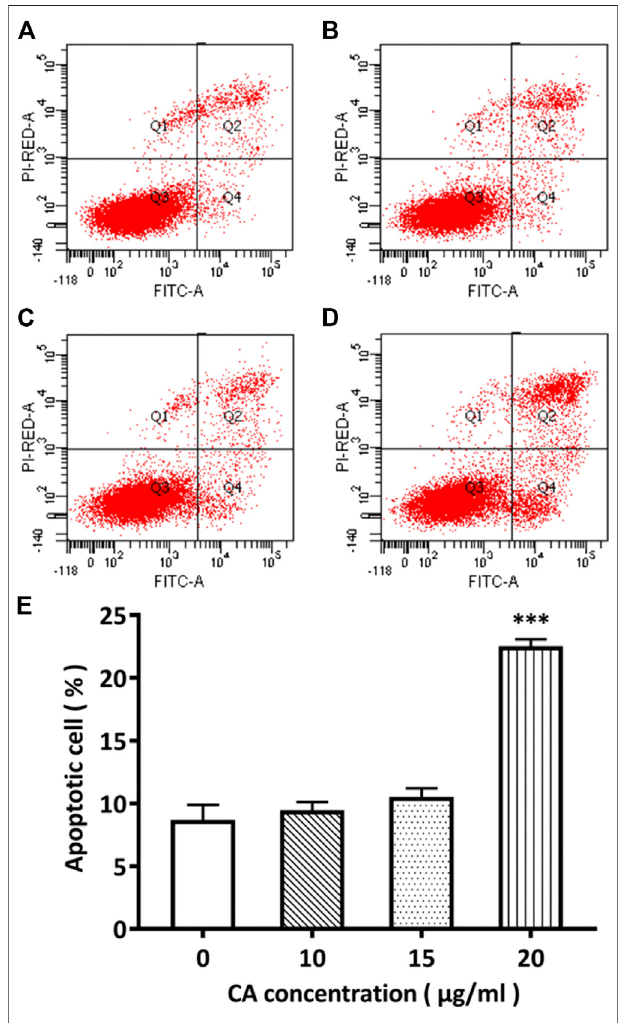
FIGURE 8 | Comparison of the apoptotic rate of MDA-MB-231 cells administered different concentrations of cinnamaldehyde by Annexin V-FITC and PI double staining. (A) – (E) shows the cell apoptotic rate in the cinnamaldehyde groups administered different concentrations of cinnamaldehyde ( ppp compared to the control group p < 0.001). CA, cinnamaldehyde.